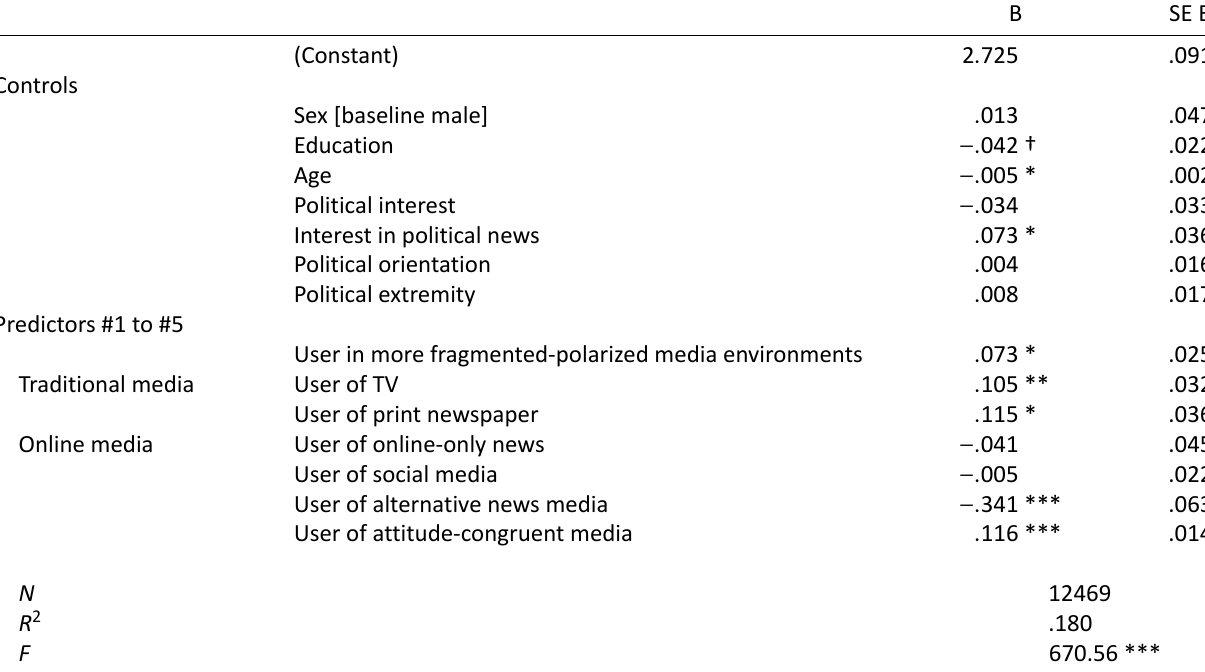
Table 3. Cluster bootstrapped regression model predicting media